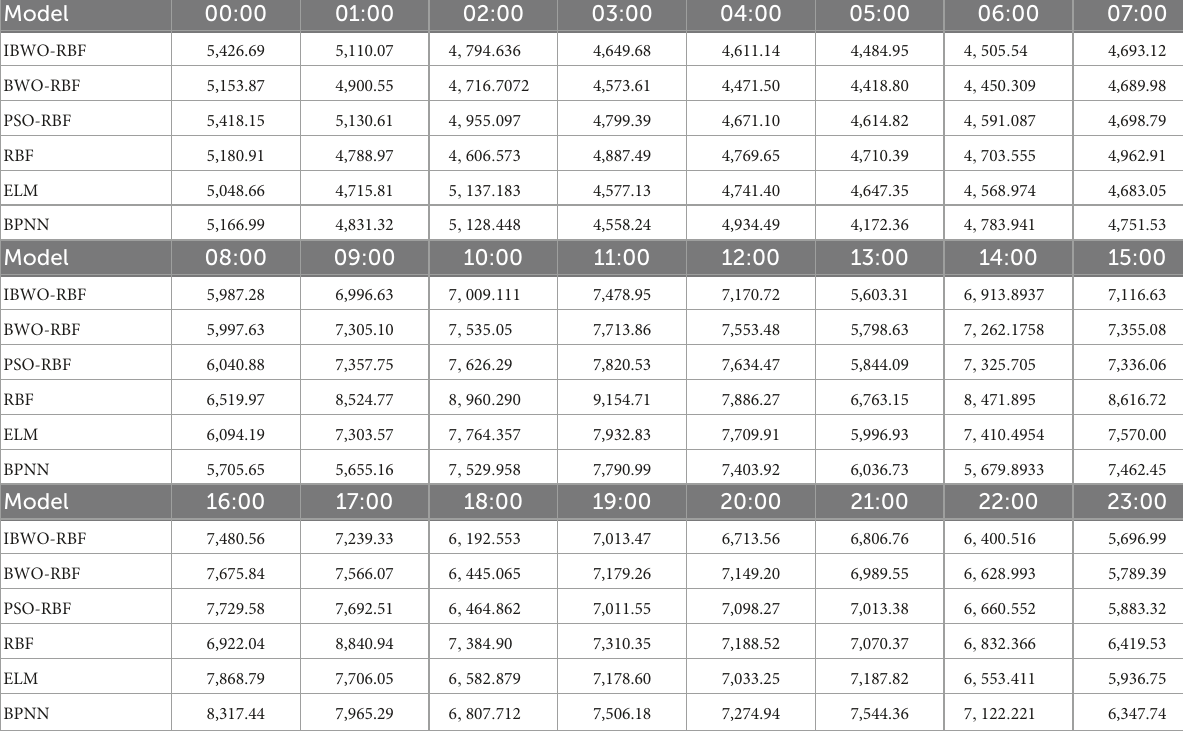
TABLE 8 Comparison of predicted values of 6 models.